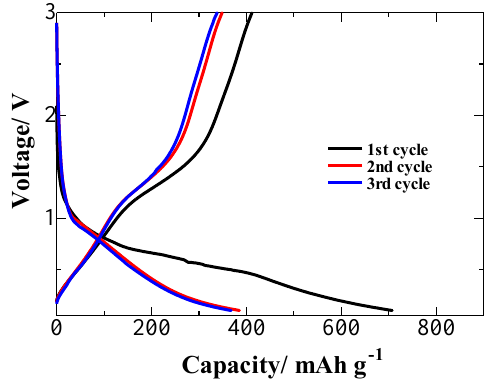
Figure 9. The charge-discharge profiles of the C@Fe 2 O 3 composites at the initial three cycles at 50 mA 50 mA g − 1 between 0.01 and 3.0 V. g −1 between 0.01 and 3.0 V.